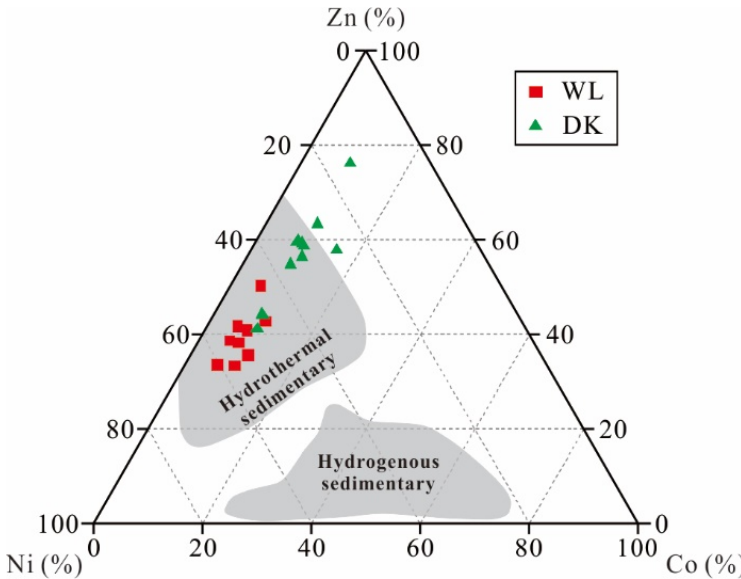
Figure 4. Ternary diagrams showing the relative distribution of Ni-Co-Zn [58].